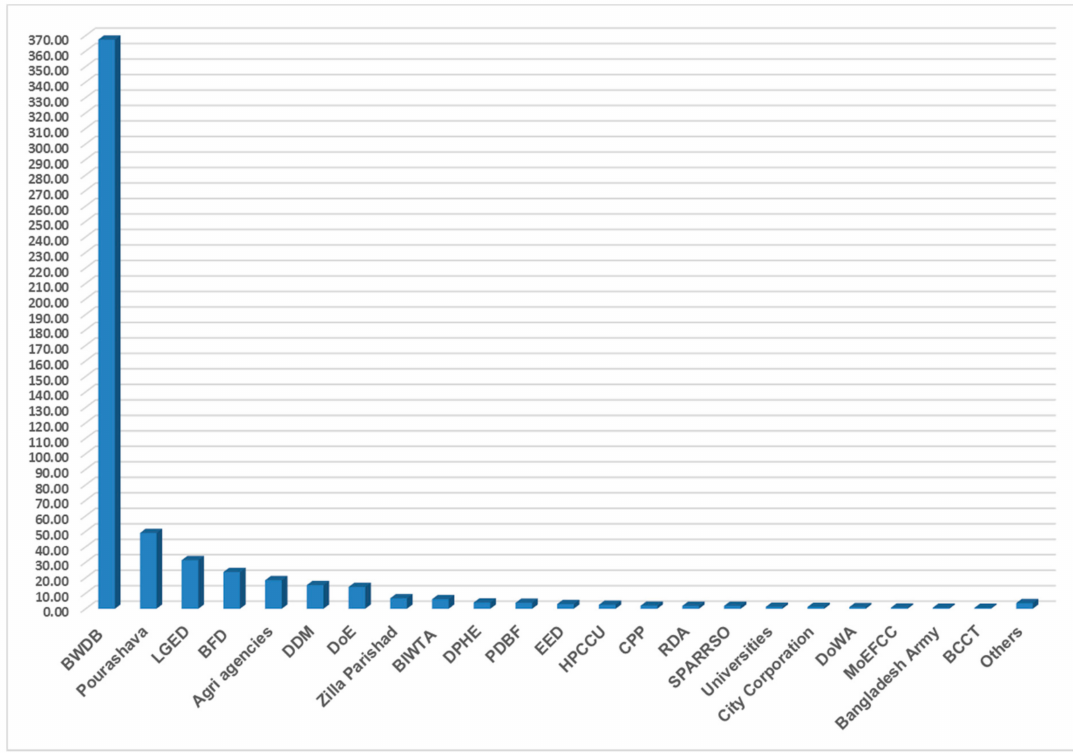
Figure 5. Implementation of climate adaptation funds by sectoral lead agencies based on Bangladesh Climate Change Trust Fund (BCCTF) projects from 2009 to 2017. Note: Data collected from Rahman